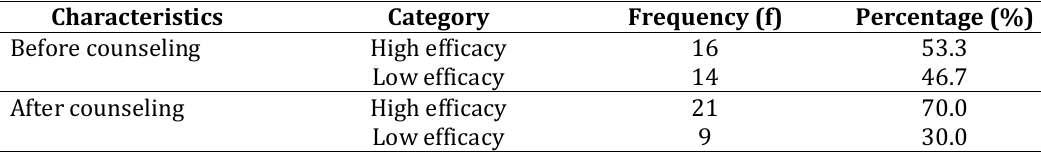
Self-Efficacy of the Comparison Group Characteristics